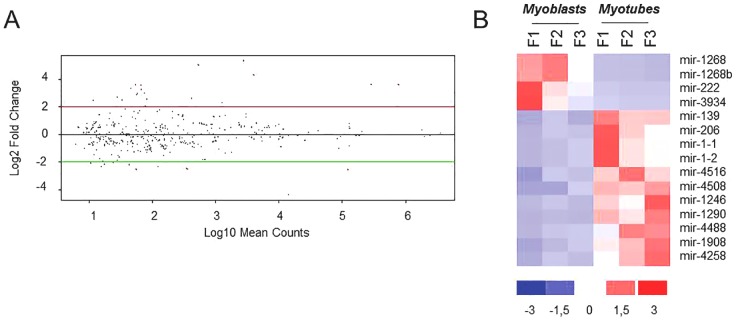
MiRNA modulation in FSHD myogenesis.A) DEseq analysis of miRNAs differentially expressed in FSHD myotubes vs FSHD myoblasts (FSHD differentiation). MiRNAs showing a modulation with log2FC≥2 and a p-value<0.05 are shown as red dots. B) Hierarchical clustering of the 15 modulated miRNAs (11 up-regulated and 4 down-regulated) in regard to the analyzed samples. F1:MX00409MBS; F2: MX03010MBS; F3:MX04309MBS, FSHD cell lines (see Table S1).